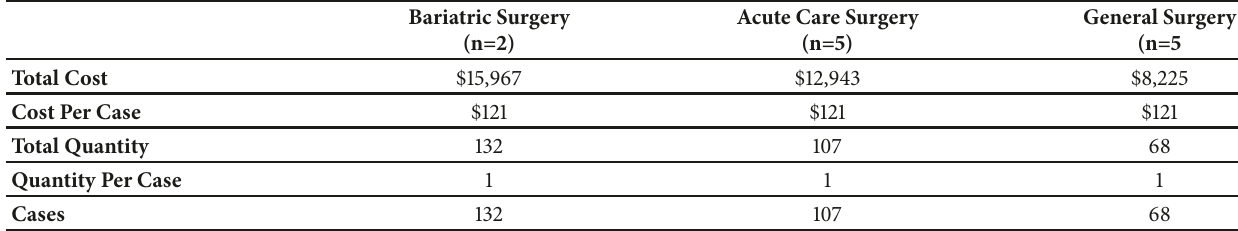
Table 4: Pack Lap Chole